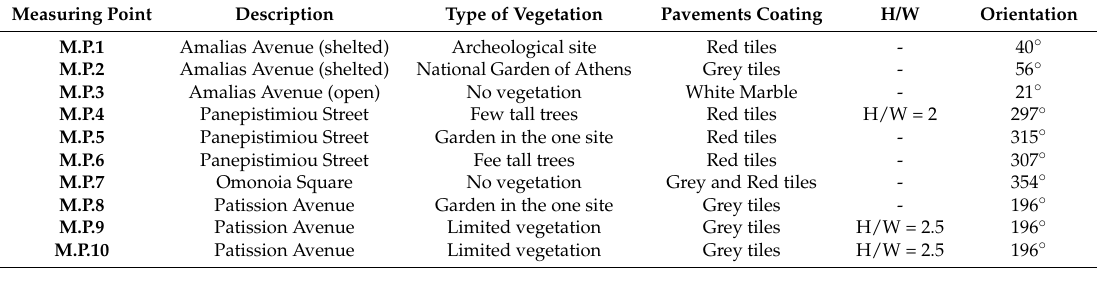
Table 1. The monitoring route.